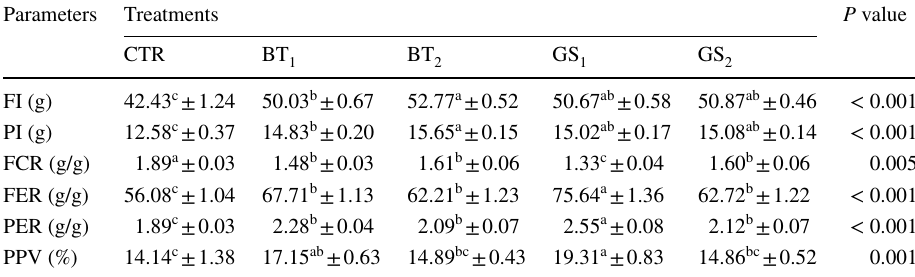
CTR, control fish group reared in clean water